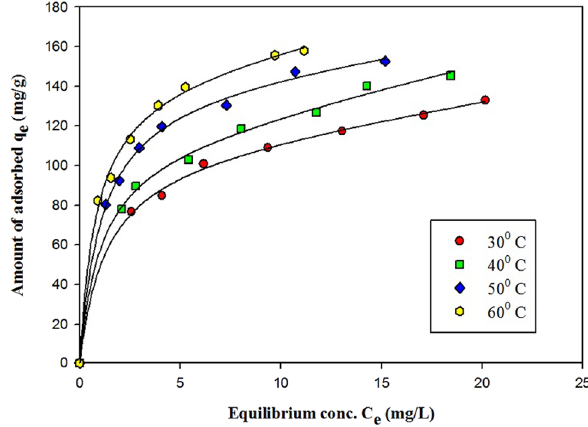
Fig. 6 Plots of adsorption isotherms for adsorption of aqueous meth- ylene blue solution on coconut coir dust at different temperature and pH